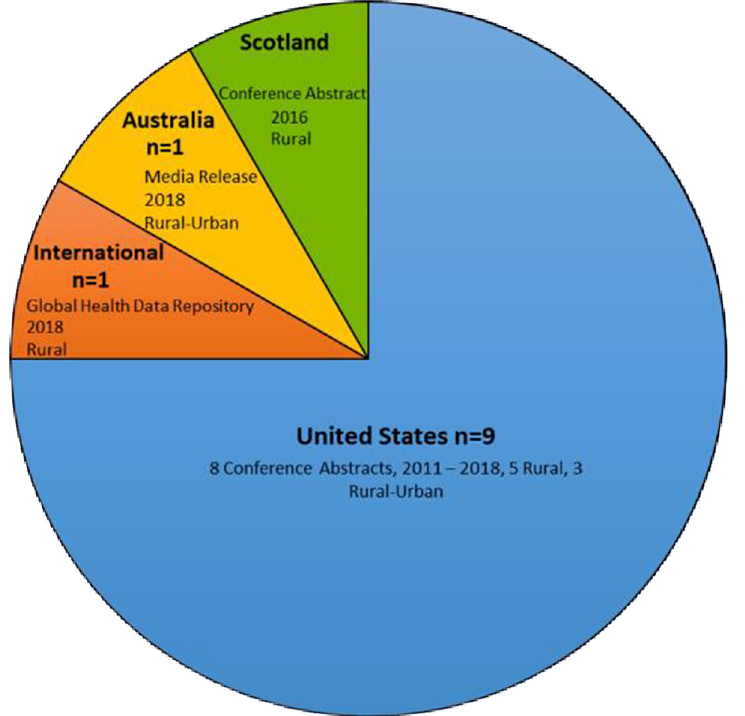
Fig 3. Characteristics of included grey